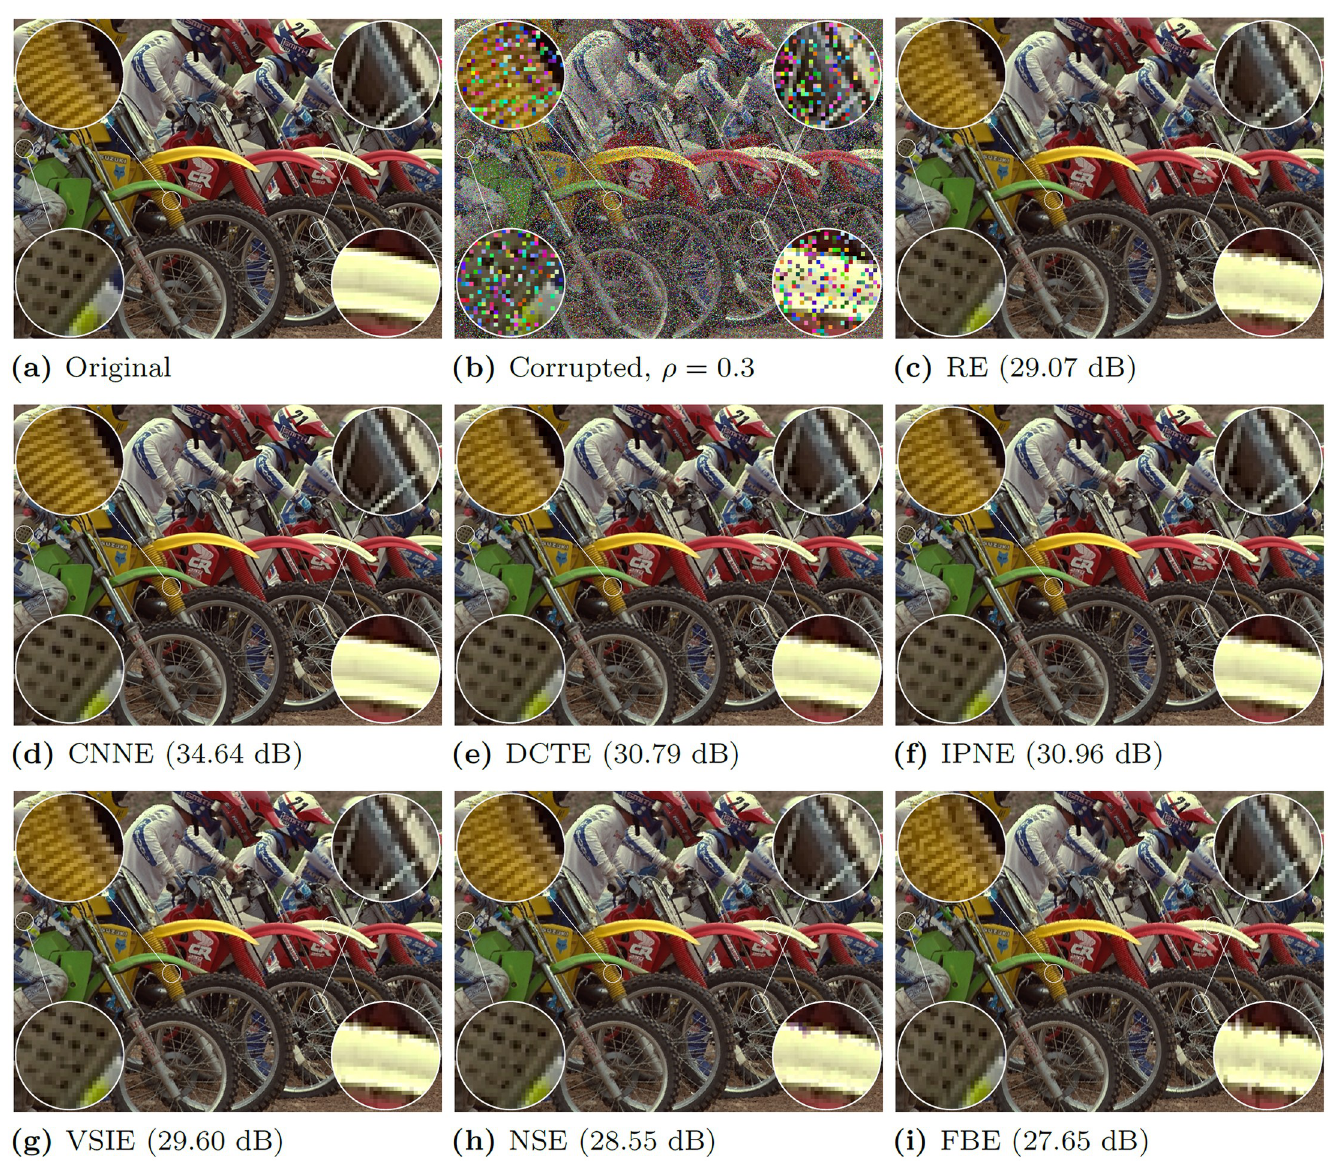
Fig 5. Impulse suppression performance on artificially corrupted image. MOTOCROSS image ( ρ = 0.3) using the best detector—CNND and all tested estimators, is presented (PSNR values are provided).